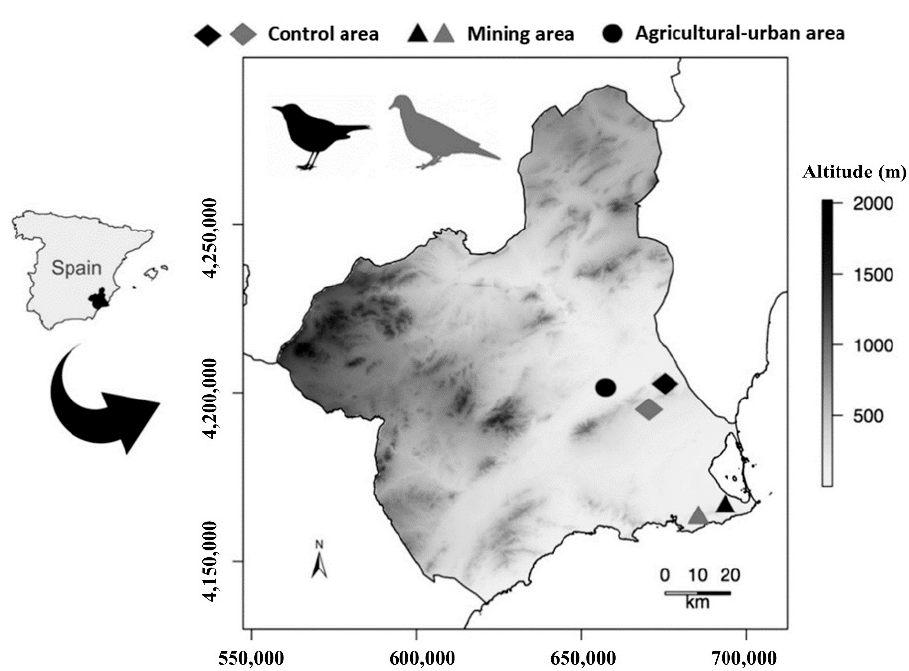
Figure 1. Map showing the investigated scenarios in the province of Murcia, Spain. The sampling areas are represented by a rhombus, triangle, and circle for control, mining, and agricultural–urban areas, respectively. The sampling areas for the different species are shown in different color: black figures for Turdus merula and grey figures for Columba livia .